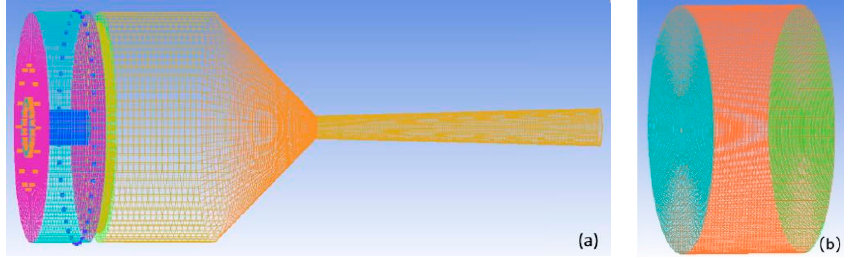
Figure 3. Configuration of the third meshes: ( a ) internal flow field and ( b ) external flow field.